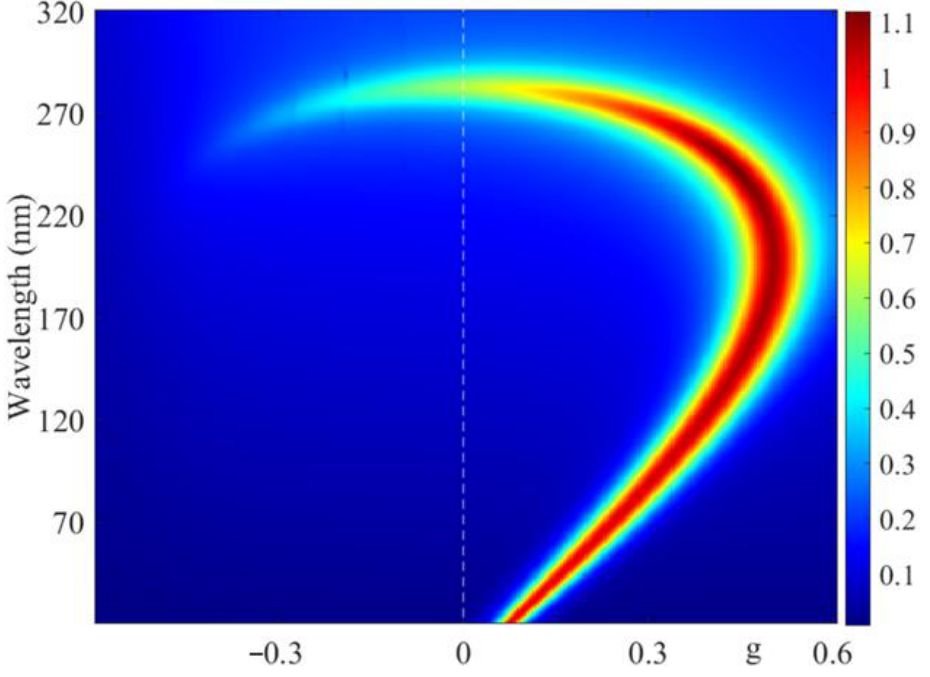
Figure 11. The evolution of light energy density spectra 𝑤 in the dichroic CLC layer with a change in g. The incident light has diffracting EP.